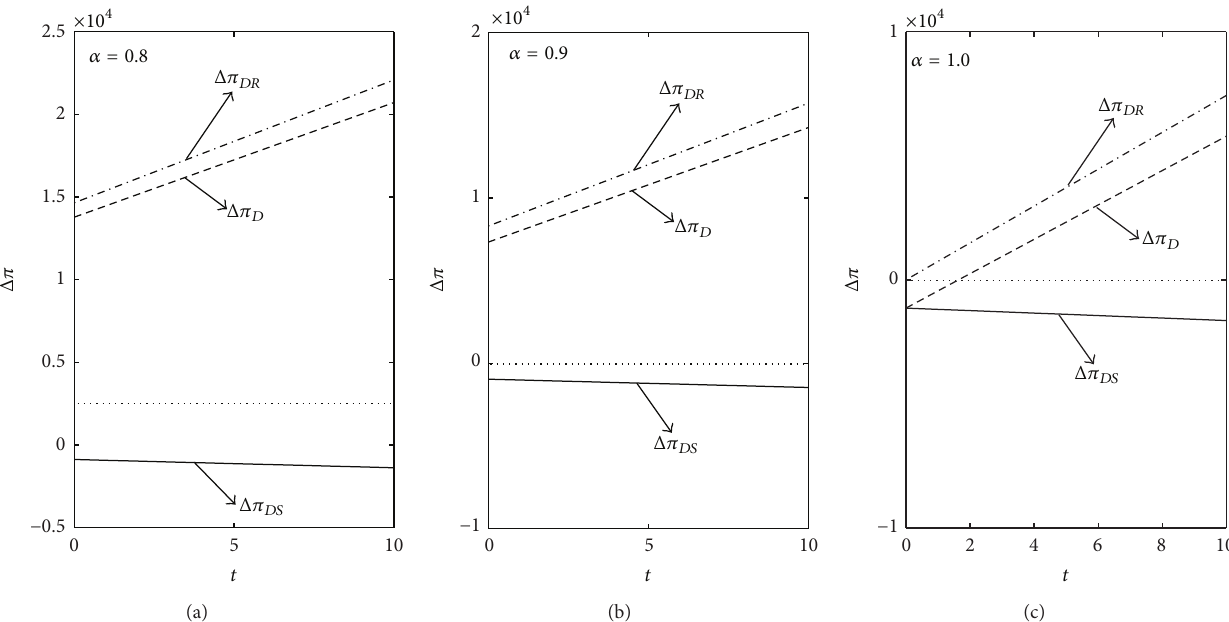
Figure 8: Impact of adopting RFID technology on the profit of decentralized supply chain and its players.